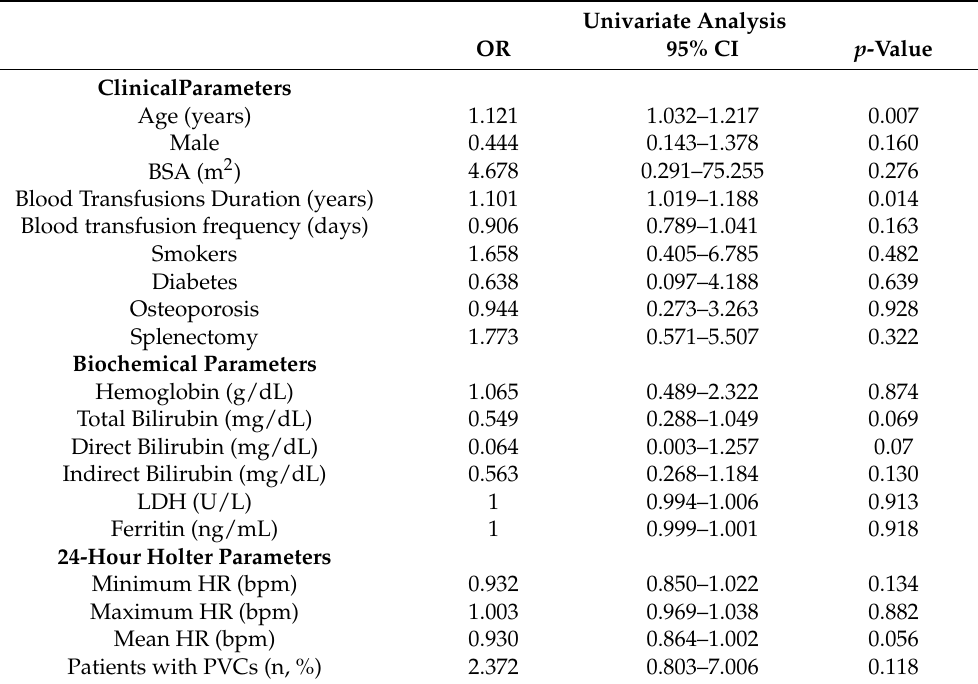
Table 3. Clinical, biochemical and 24-hour-Holter univariate associates of premature atrial contrac- tions > 24/day in β -thalassemia-major